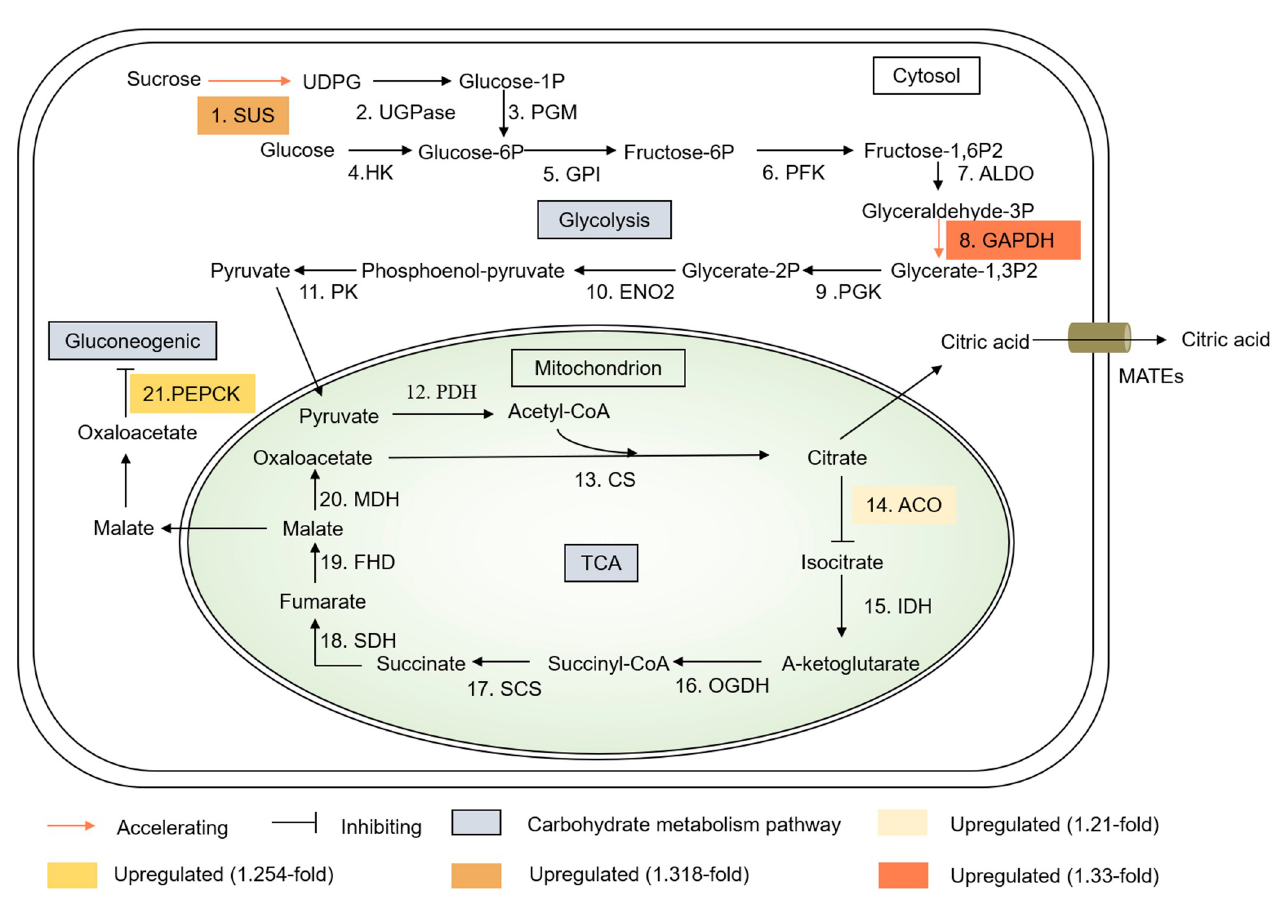
Fig 4. DPPs involved in carbohydrate metabolism. 1. SUS, sucrose synthase; 2. UGPase, UDP-glucose pyrophosphorylase; 3. PGM, phosphoglucomutase; 4. HK, hexokinase; 5. GPI, glucose-6-phosphate isomerase; 6. PFK, phosphofructokinase; 7. ALDO, aldolase; 8. GAPDH,